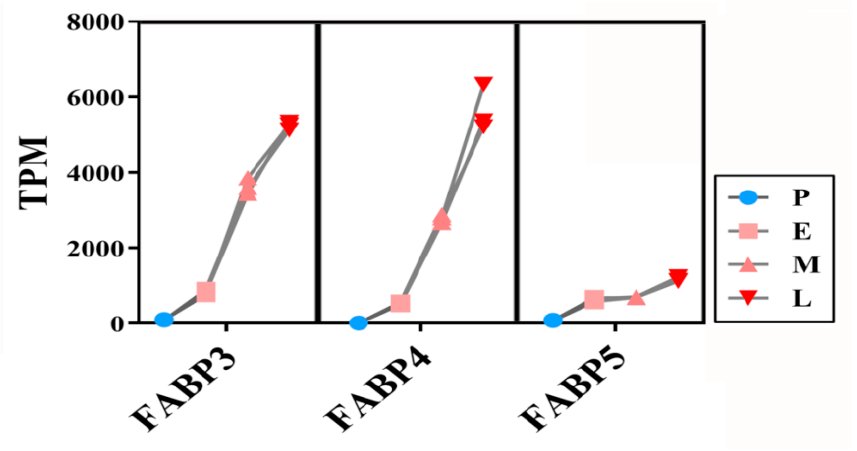
Figure 9. Expression changes of FABP genes during the lipogenesis of SMSC. Sequencing data, n = 3.